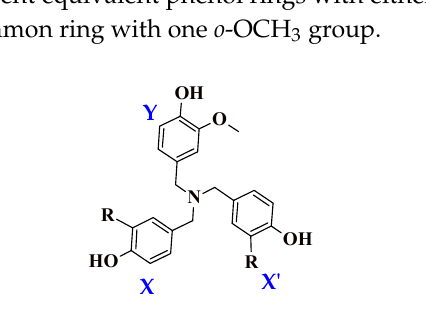
Figure 2. General structure of the compounds and notation (X, X’ and Y) for the phenol rings. R = H, electron-donating or electron-withdrawing group.